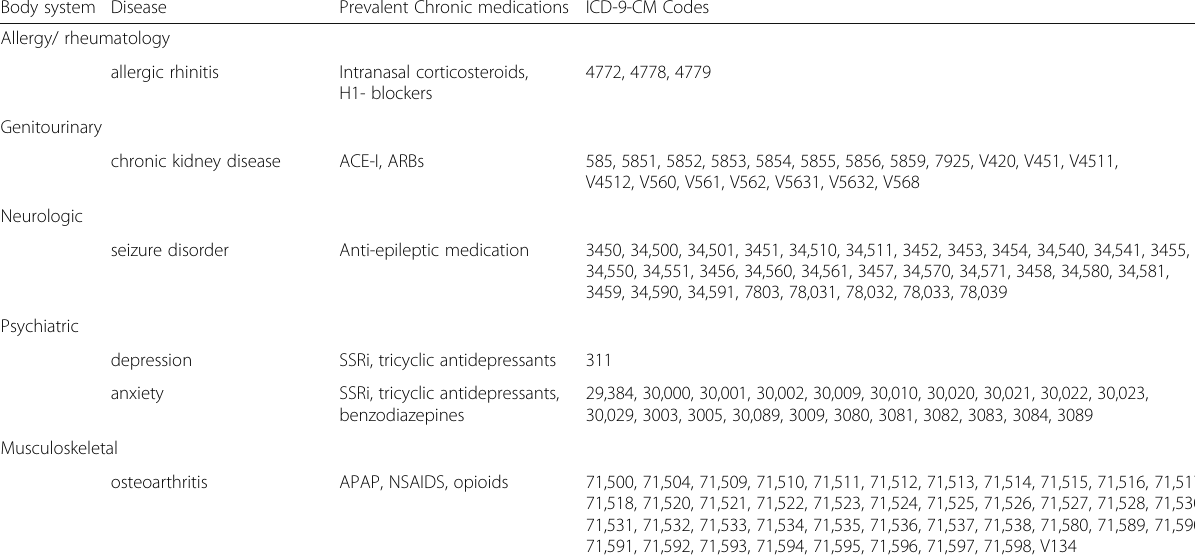
Table 4 Baseline comorbidities and associated ICD-9-CM codes (Continued)